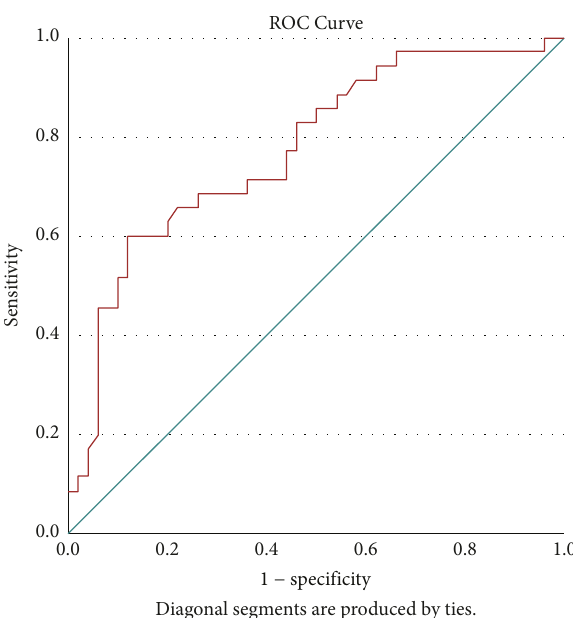
Figure 6: ROC curve depicting the discriminant function of S/ FP ∗ 10 (B) to be categorized as mild ARDS as per Berlin definition (AUC: 0.773, p < 0 . 001, cut-off value ≥ 190, sensitivity: 69%, (B) � (SpO 2 ∗ 10)/(FiO 2 ∗ PEEP) (the values obtained at one hour after intubation and mechanical